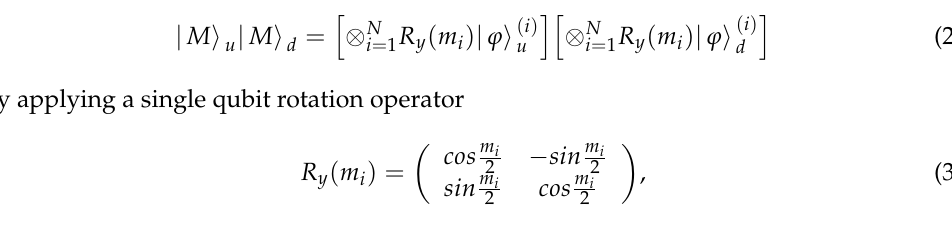
Figure 1. Basic structure of the quantum message authentication protocol based on quantum three-pass protocol. Similar to quantum three-pass protocol, which transmits bits three times, our protocol performs three quantum state transmissions. After three attempts of quantum state transmission, Bob finally acquires quantum message states | M (cid:105) = ⊗ N R y ( m i ) | ϕ (cid:105) i and | M (cid:48) (cid:105) . He then uses a swap test twice to confirm the similarity of the two arbitrary quantum states d d i = 1 | M (cid:105) , | M (cid:48) (cid:105) and bit message sequence M . K AB and K H denote the secret key sequences that Alice and Bob previously u d shared. S is the private key sequence that only Alice knows, and B is the one known only to